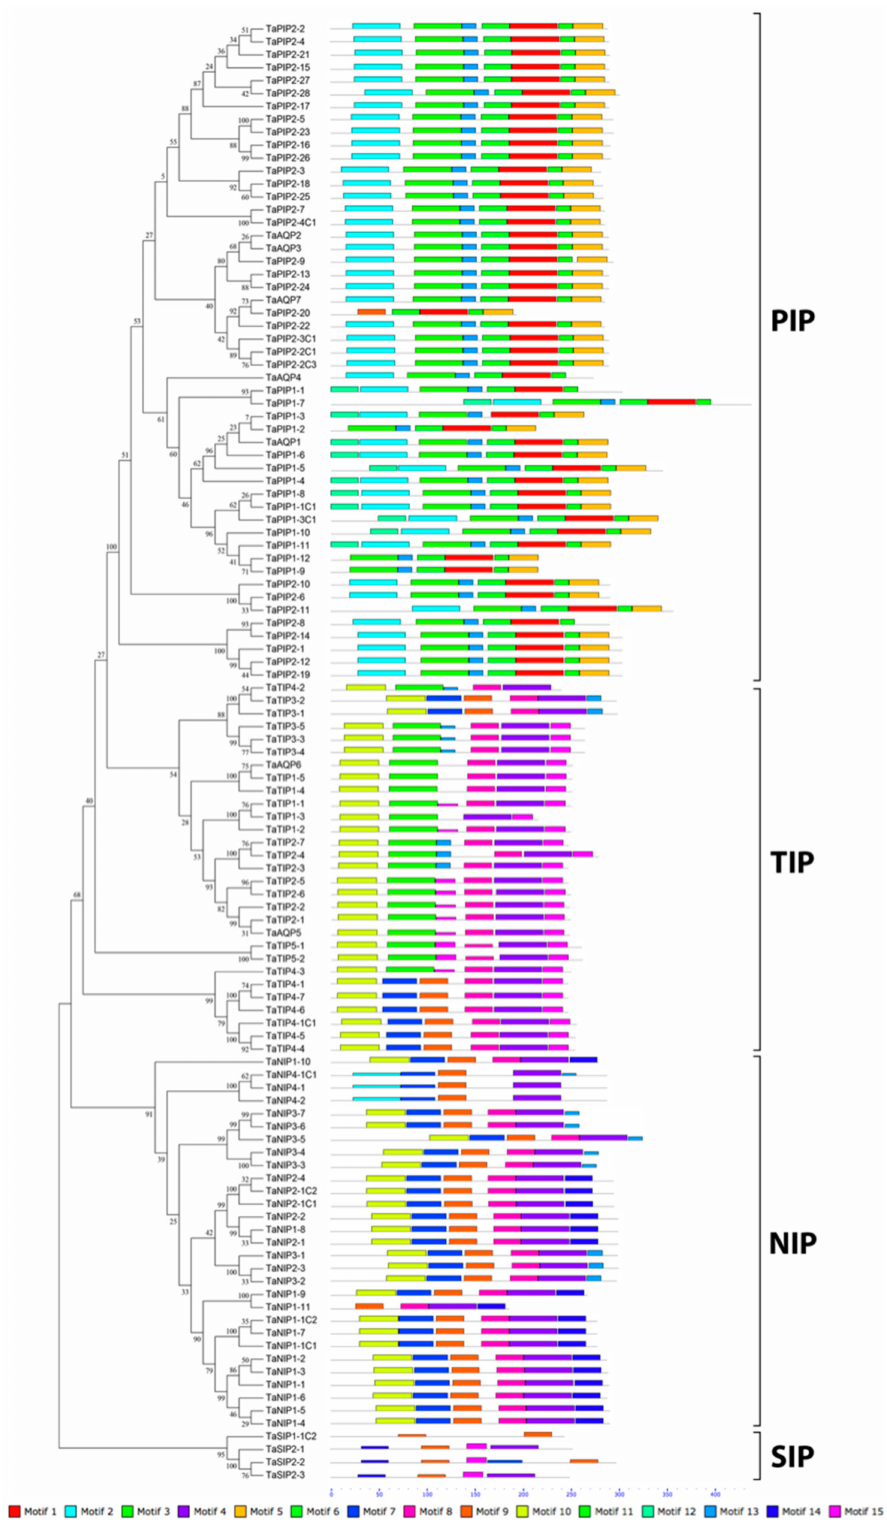
Figure 3. Identification of conserved motifs in wheat AQPs. The MEME database identified 15 motifs using the complete amino acid sequence represented proportionally by grey lines. Each color represents a different motif described in Table